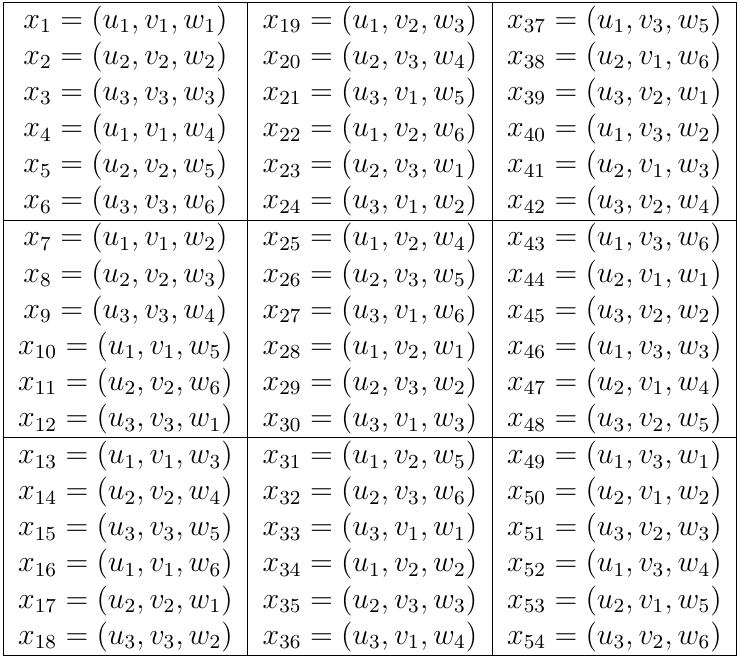
(cid:3) K (cid:3) K 3 3